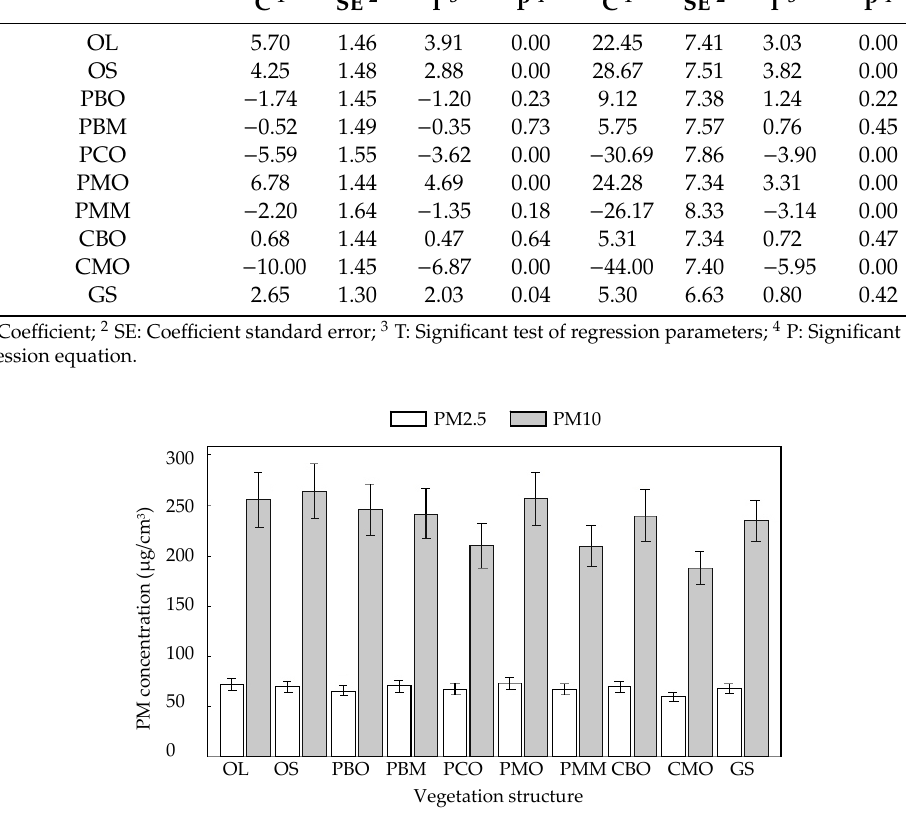
Table 6. Generalized regression analysis of PM concentration and vegetation structure in urban space I. PM2.5 Vegetation structure Vegetation Structure